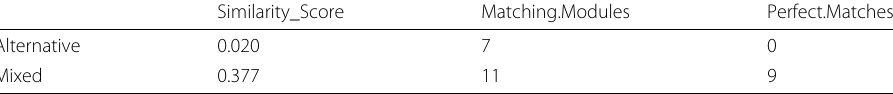
Table 6 Comparison of modular structures detected using the Infomap algorithm between the Main network and the Alternative or Mixed networks, based on module node similarity Similarity_Score